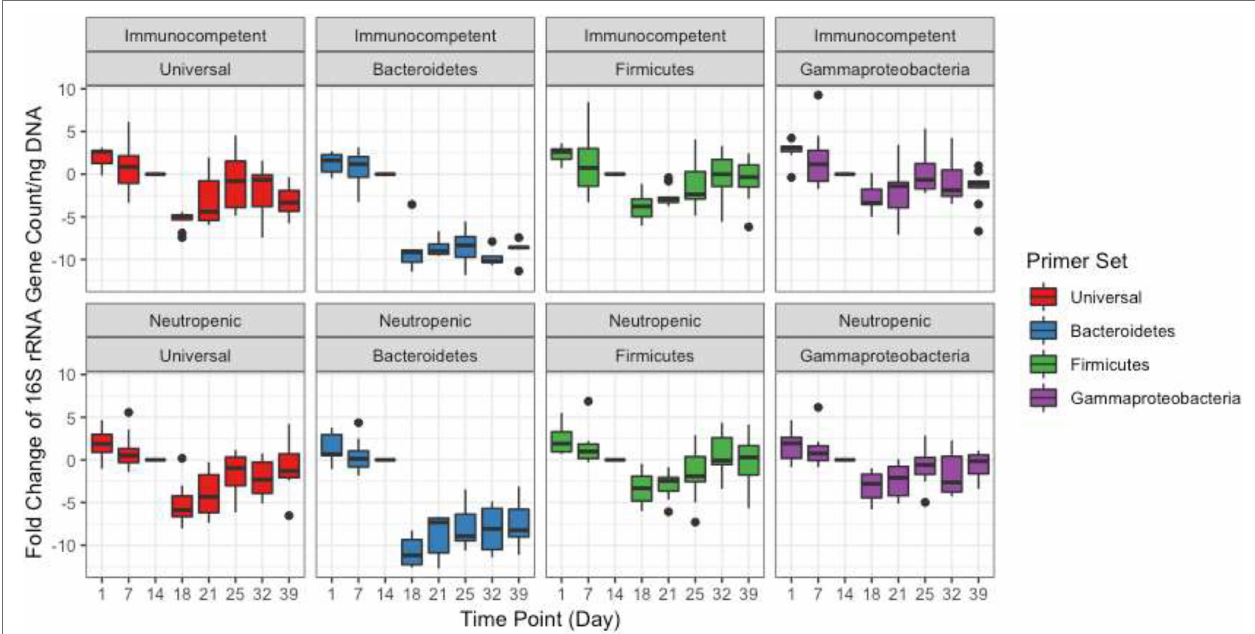
FIGURE 1 | Bacterial quantification of the TZP2 experiment. Box and whiskers plots show the fold change of the 16S rRNA gene count as generated by quantitative PCR (qPCR) from DNA extracted from stool for all mice (immunocompetent and neutropenic shown separately) at each time point as compared to Day 14, the time-point immediately prior to antibiotic